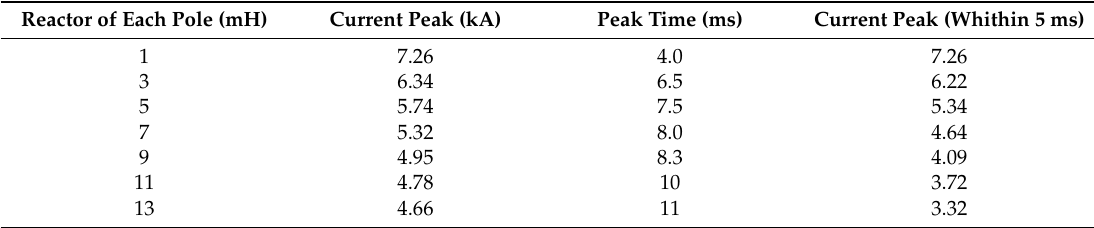
Table 7. Discharge current I 2 under different current limiting reactor of converter station II. Reactor of Each Pole (mH)